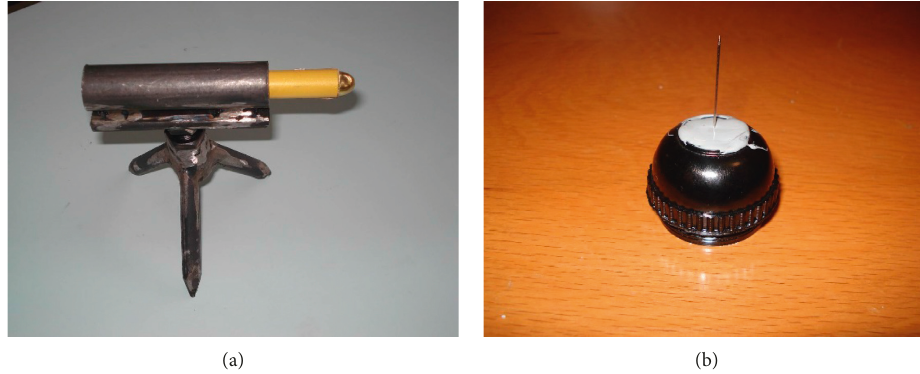
Figure 5: Tensile strain measuring equipment. (a) Rotary laser generator. (b) Indicator.